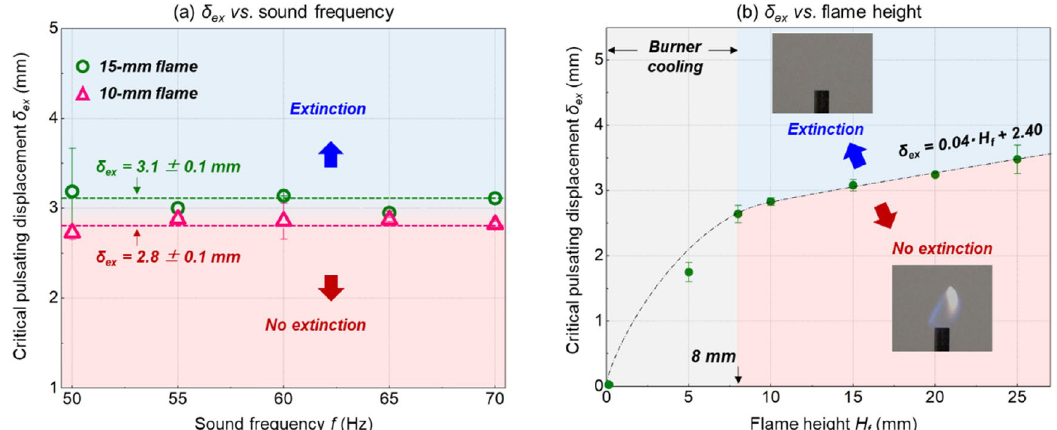
Figure 4. Dependence of critical pulsating displacement on ( a ) sound frequency and ( b ) flame height.